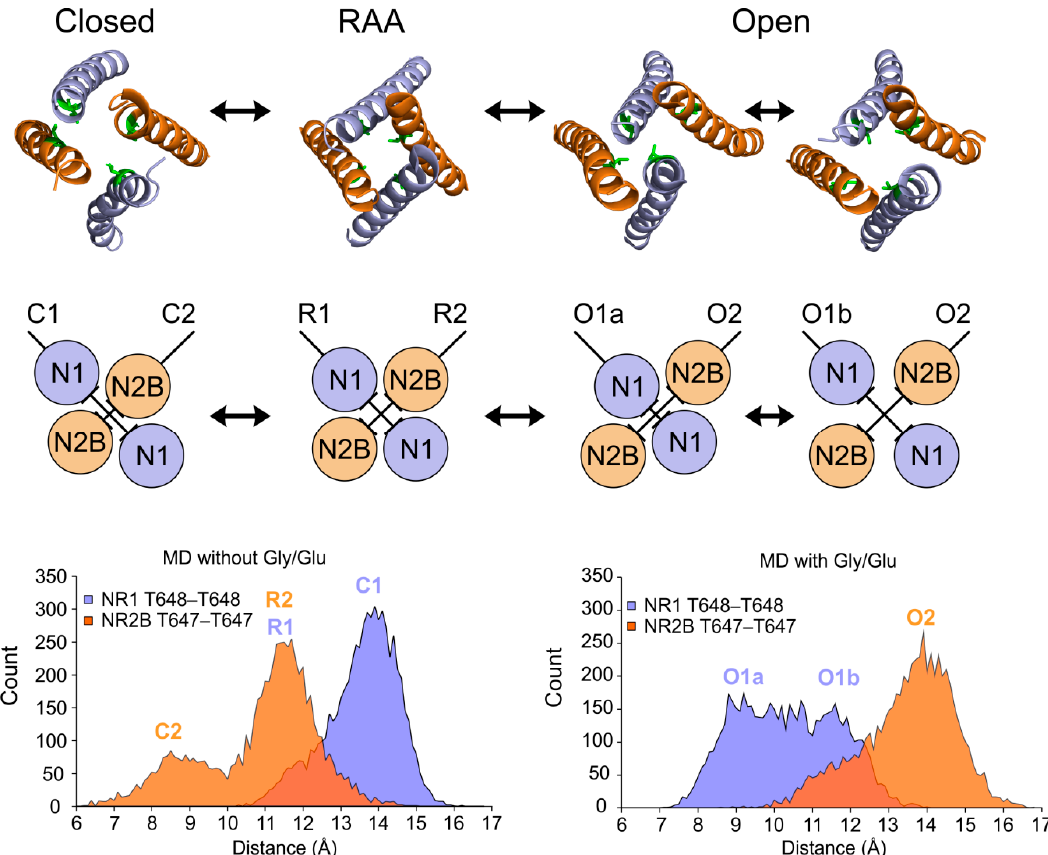
Figure 4. Comparison of the arrangements of inner ion-channel helices (M3 helices of the TMD) between the different functional states of the NMDA receptor. ( Top ) Snapshots of M3 helices from MD simulations of NMDA receptor closing and opening. Threonine residues forming the TTTT gate are shown as green sticks. ( Middle ) In the closed state the MD simulation of the unliganded receptor led to a closer contact of GluN2B M3 helices (orange circles, C2 distance), while GluN1 helices (blue circle) were more separated (C1 distance). Relative M3 helix distances inside the channel pore are indicated by the ├┤ symbols. The RAA state shows the M3 helices in a symmetrical arrangement (R1 and R2 distances), however, this orientation represented a transition between the closed and the open state. Contrary to the unliganded case, the MD simulation of the liganded receptor led to a separation of GluN2B M3 helices as a consequence of the LBD mechanical signal (O2 distance), while the GluN1 M3 helices transiently formed a closer contact (O1a distance). ( Bottom ) Histograms of C α –C α distances in Å between the gating threonine residues across the channel extracted from the MD simulation, GluN1–GluN1 (Thr648–Thr648) shown in blue and GluN2B–GluN2B (Thr647–Thr647) in orange. During the opening simulation GluN1 M3 helices oscillated between two maxima of the distance distribution (corresponding to energy minima) with distances between the gating Thr648–Thr648 distances across the channel of around 8.5–11.5 Å. The shorter O1a distance corresponded to the LILI gated state, while the longer O1b distance represents a fully open ion-permeable channel. The histograms summarize data from a single 150 ns opening and single closing 150 ns simulation. The distance codes in the figure were defined as follows: the C? denoted the closed state distances, R? denoted distances in the RAA state, and the O? denoted distances in the open state.